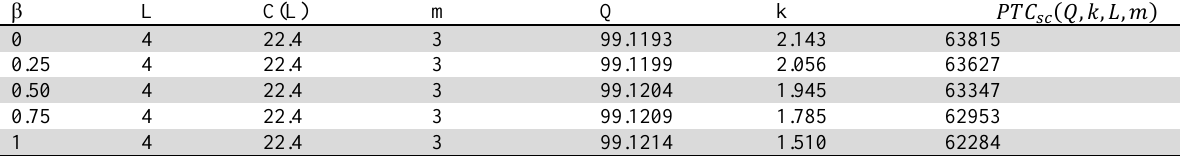
Summary of the optimal solution for numerical example 1